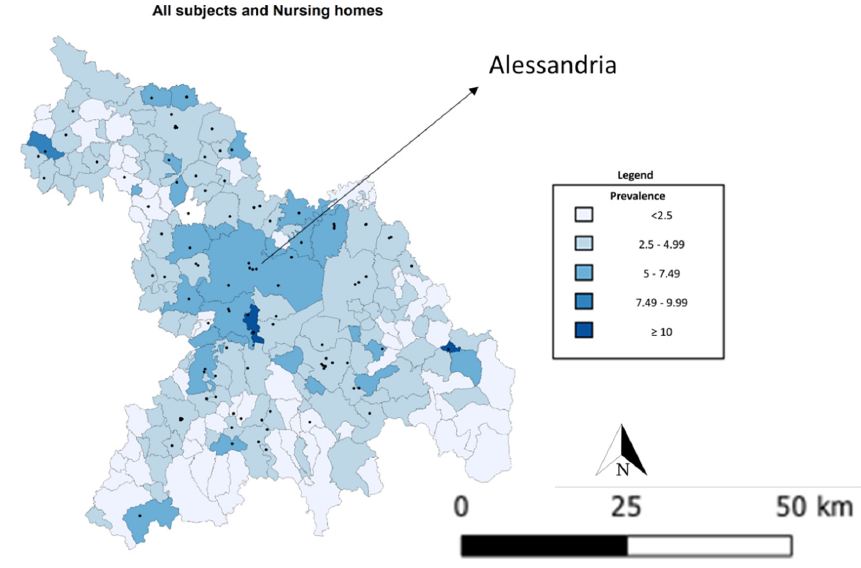
Figure 3. Choropleth map of Alessandria LHA. Colors represent the percentage of positive NP swabs divided by population numbers while nursing homes are reported as black dots. Figure 4 and Appendix Figures A2 and A3 display the geographical distributions of positive NP swabs by age and gender. The number of towns/areas with a higher preva- lence of positive subjects increased with age, and same the consideration can be made for females versus males. Focusing our attention on towns with a high prevalence of positive NP swabs among older subjects (more than 65 years old), we observed the presence of a potential cluster of cases that occurred in Sale and Castellazzo Bormida (April 2020), Vil- lanova Monferrato (September 2020), Quargnento (October 2020), Basaluzzo and Bassignana (November 2020) and Valmacca (December 2020). All of these can be associ- ated with outbreaks in nursing homes present in these towns